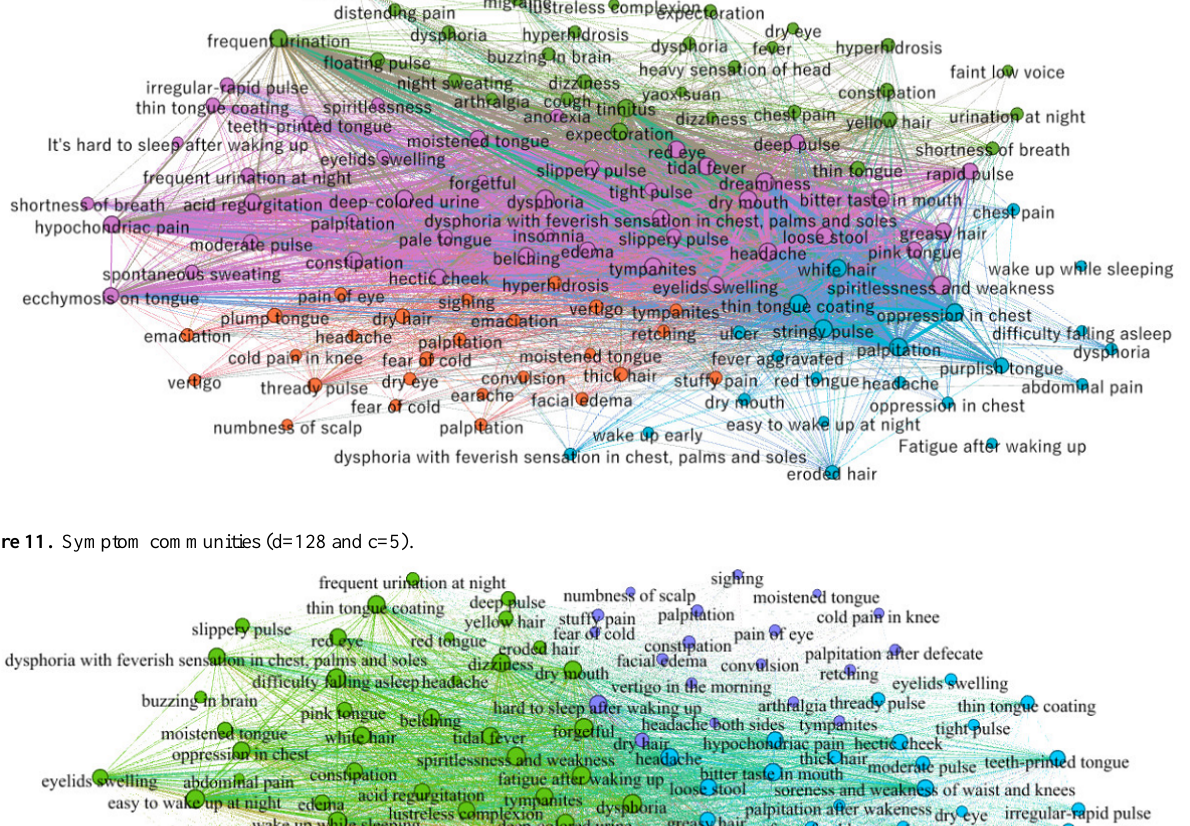
Figure 10. Symptom communities (d=128 and c=4).